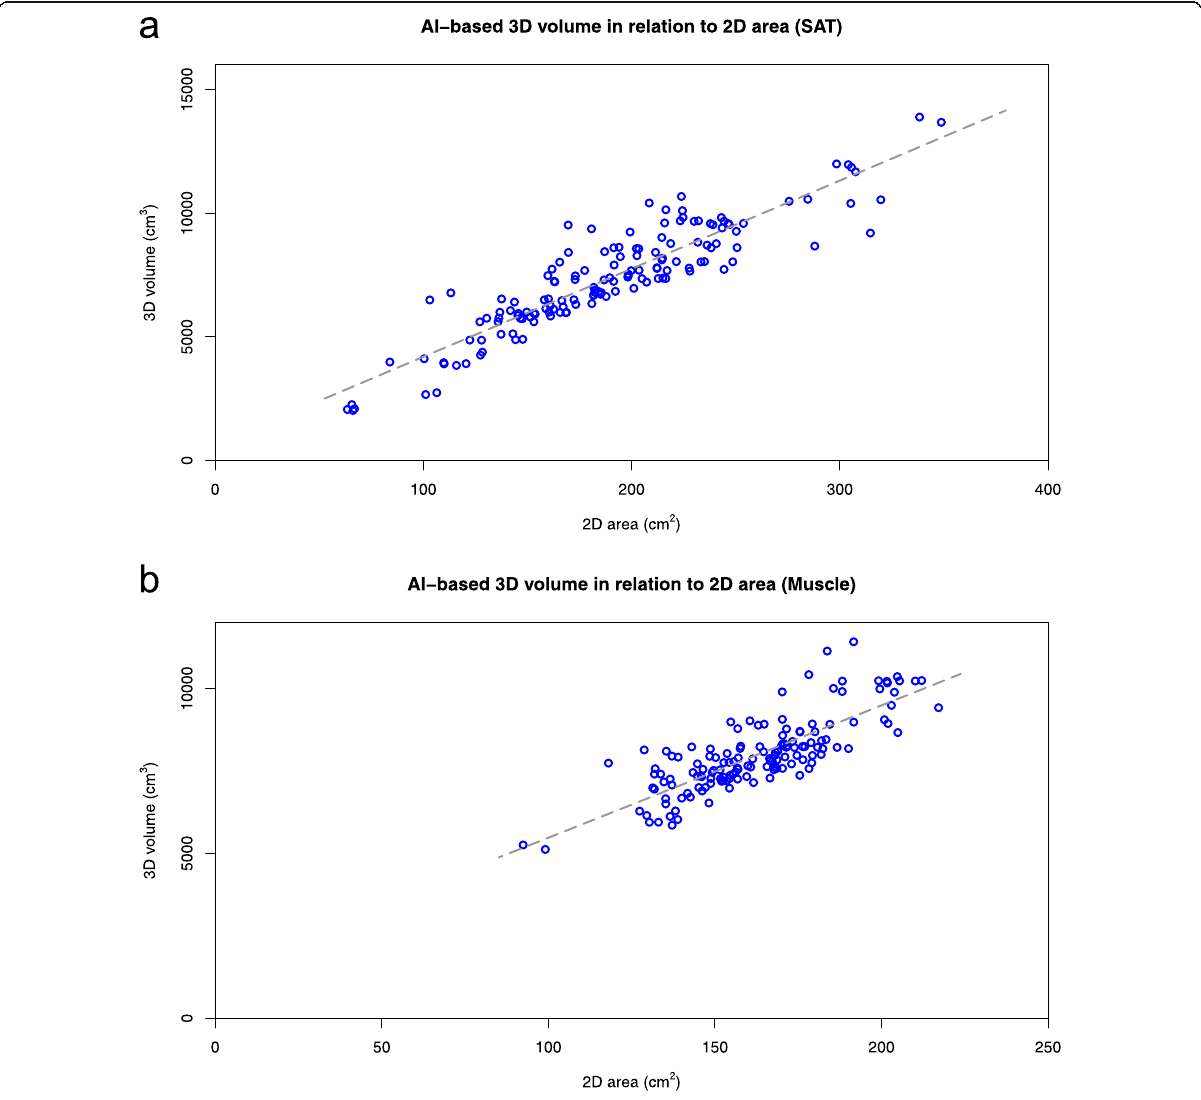
Fig. 2 Relation between AI-based 3D volume and L3 slice 2D area for SAT ( a ) and muscle ( b ) for 148 computed tomography studies in 74 patients. 2D Two-dimensional, 3D Three-dimensional, AI Artificial intelligence, SAT Subcutaneous